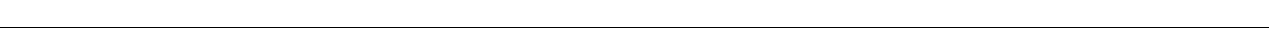
Fig. 4d; correct response latency, phase: F 2,15 ¼ 1.992, P ¼